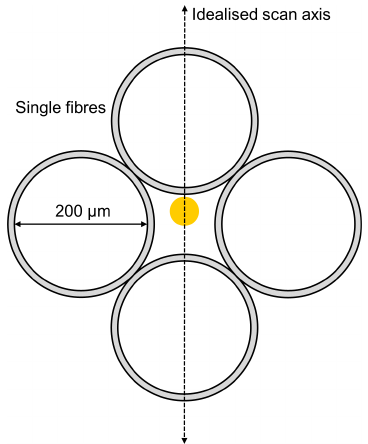
Figure 5. Sketch of the fibre bundle placed in the focal point of the telescope of the MPIC instrument. The grey parts indicate the gladding (additional 20µm) of the fibres. The white circles repre- sent the light-conducting part of the single glass fibres with a diam- eter of 200µm, while the yellow spot indicates the idealised image (neglecting aberration and other effects) of the xenon lamp inside the telescope, which has a diameter of 7µm. Note that the size of the yellow dot is not shown at the correct scale relative to the fibre diameter and is larger than in